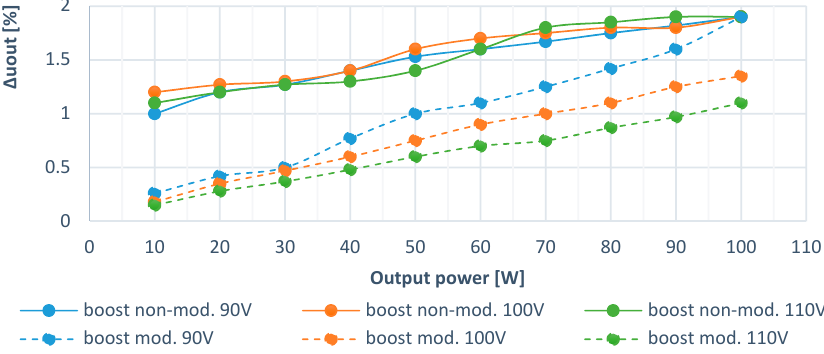
Figure 18. The dependency of output voltage ripple on output power and input voltage for proposed bi-BB converters for boost mode.